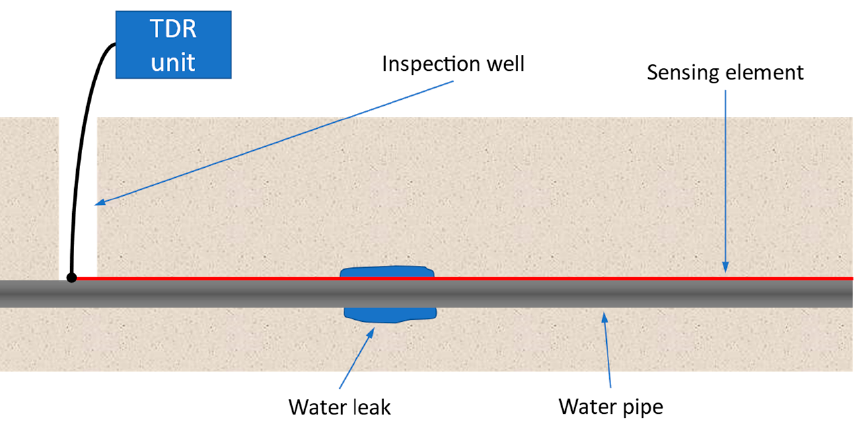
Figure 1. Representation of the on-field measurement setup for the leak localization in underground pipes based on time domain reflectometry (TDR). The sensing element (SE) is placed in the ground near the water pipe and is connected to a TDR unit through a short coaxial cable.